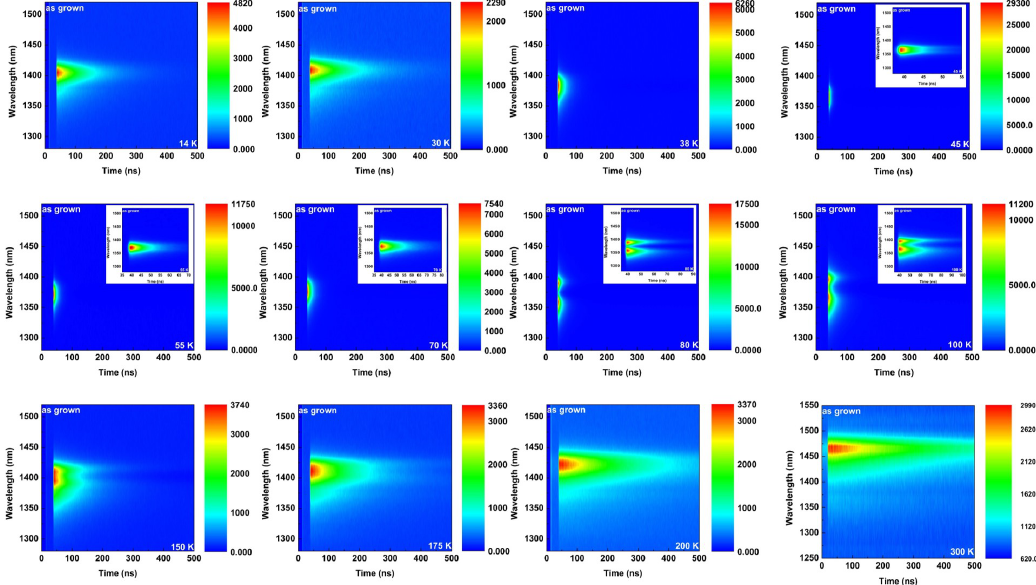
Figure 3. Overview of the time-resolved PL data for AlGaInAs